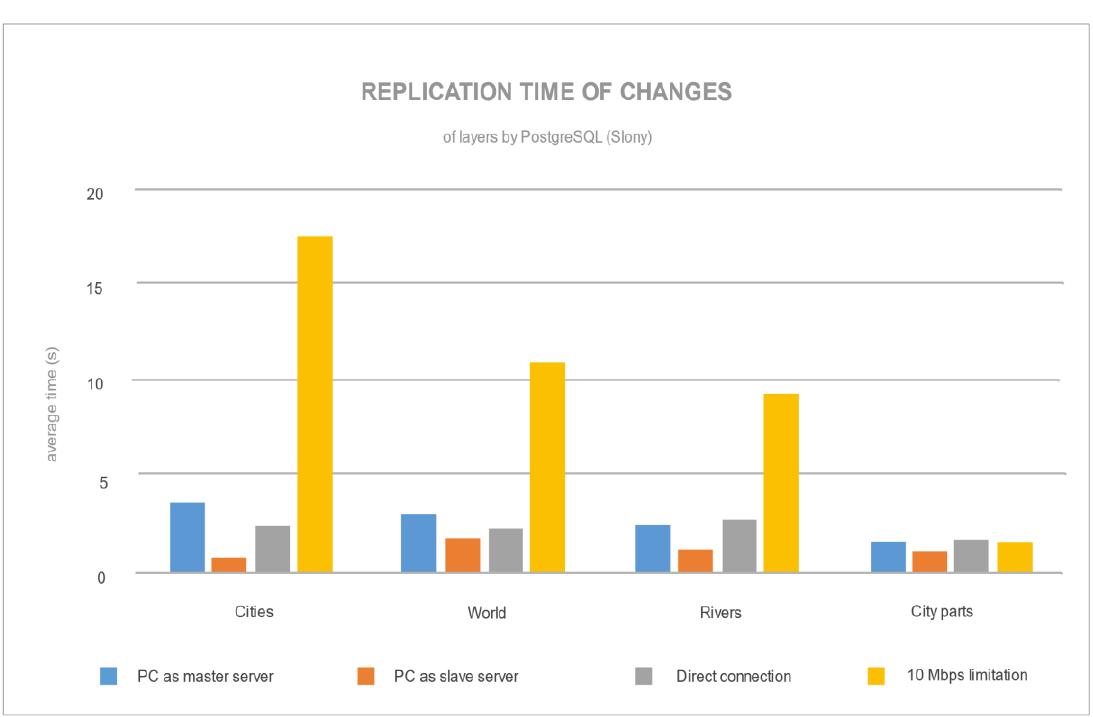
Figure 12. Average replication time of the EPEU layer for both replication solutions.